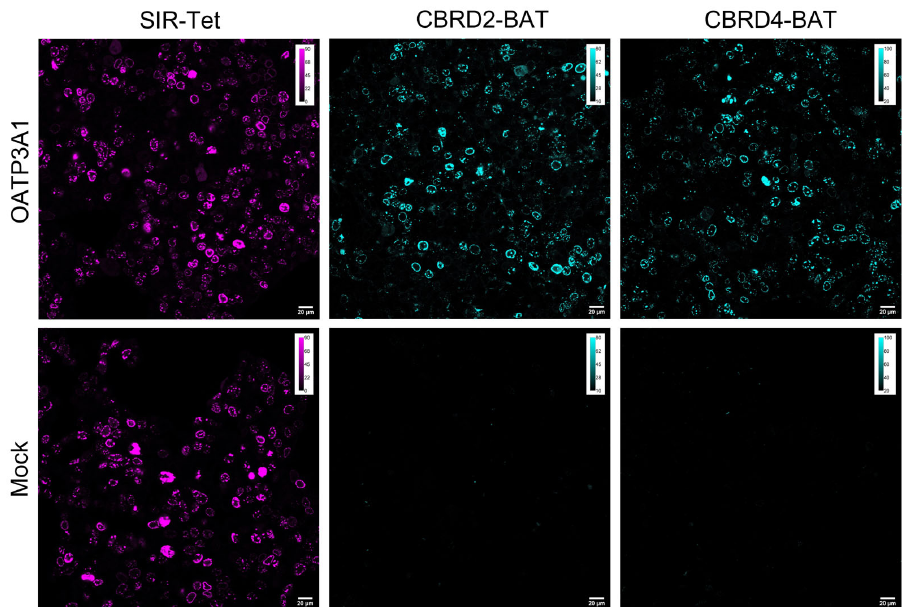
Figure 3. Confocal microscopy images of LaminA-HaloTag expressing OATP3A1 positive and negative (mock) cells pretreated with HaloBCN (3 µ M, 60 min) and treated with non-permeable fluorescent dyes CBRD2-BAT (3 µ M, 30 min) and CBRD4-BAT (10 µ M, 30 min) in complete DMEM medium. Fluorescent labeling with membrane-permeable SiR-Tet (magenta) serves as positive control of transfection. Scale bar: 20 µ m; Spectral detection: ( SiR-Tet ); λ exc : 638 nm/ λ em : 650–800 nm; dyes CBRD2-BAT and CBRD4-BAT : λ exc : 552 nm/ λ em : 565–800 nm. Objective: 40 × .